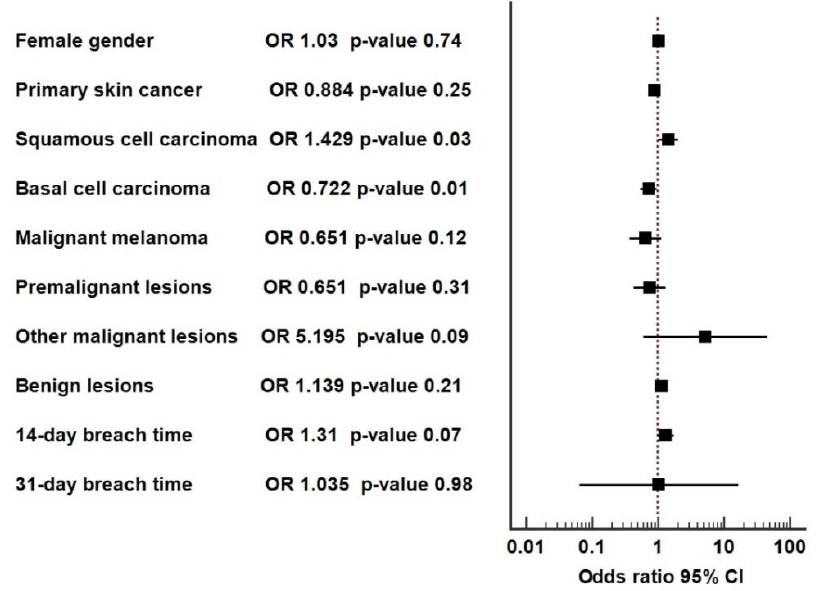
Figure 2. Forest plot for the face-to-face ( left ) and virtual video/photo consultation ( right ).